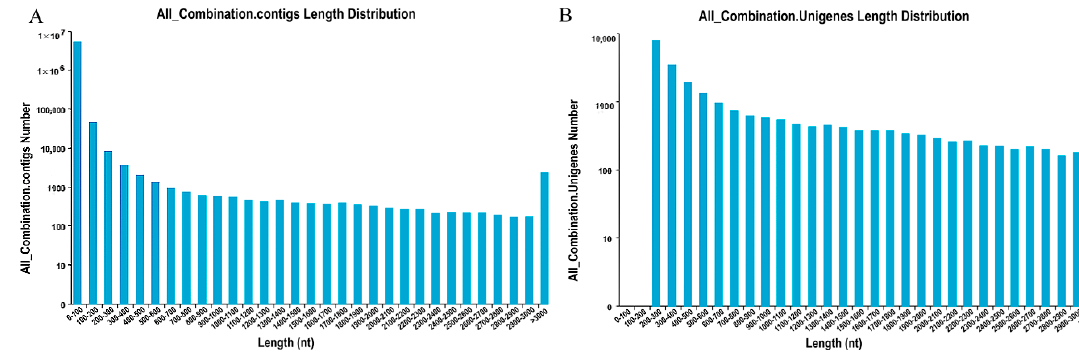
Figure 1. Raw data of M. roridum transcriptome: ( A ) the distribution of contigs in M. roridum transcriptome; and ( B ) the distribution of unigenes in M. roridum transcriptome.